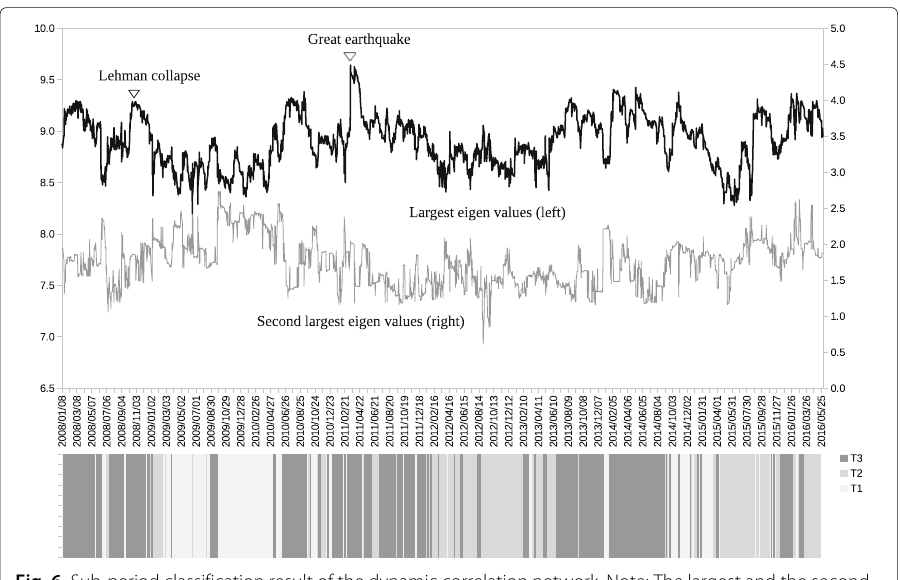
Fig. 6 Sub-period classification result of the dynamic correlation network. Note: The largest and the second largest eigenvalues of the adjacency matrix of the dynamic correlation network of sub-portfolio returns are plotted at each trading day as the twosolidlines on the top . The clustering result of the conditional adjacency matrices during the whole observation period are shown as the shadedbar graph on the bottom . T1, T2, and T3 represents the three sub-periods as the three division of the whole period as shown in Tables 5 and